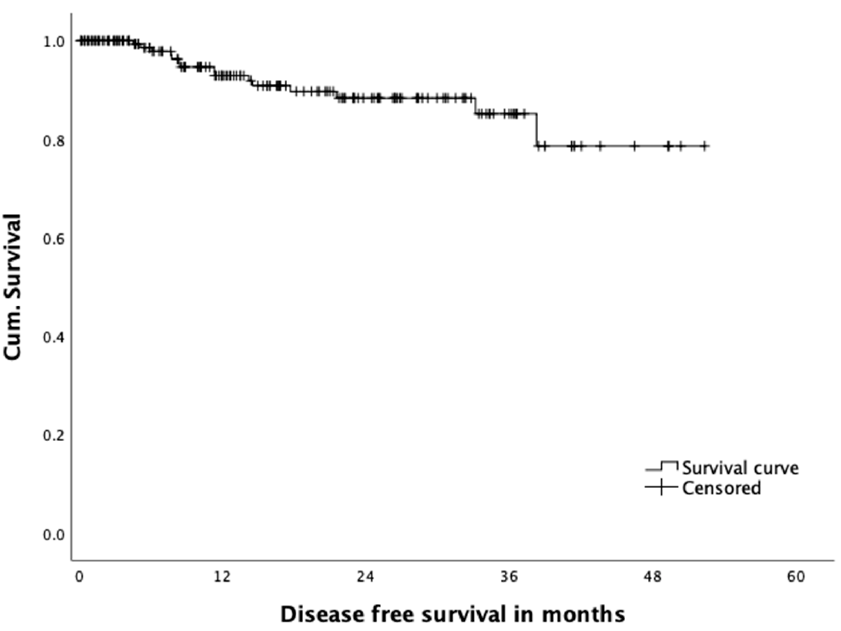
Figure 4. Overall disease free survival. Three patients (1.9%) were diagnosed with simultaneous local and systemic recurrence and further three patients (1.9%) with only local recurrence in the follow-up. A total of thirteen (8.3%) patients developed distant metastatic disease. Mean time to the occurrence of local and systemic recurrence did not differ significantly (14.2 vs. 13.9 months). Tumor recurrence significantly impacted overall patient survival (local and systemic) and is displayed in Figure 5 (36-month survival rate 41.1% in patients with tumor recurrence versus 89.3% without recurrence ( p = 0.001)). The impact of local recurrence versus systemic recurrence was compared separately in Figure 6, with a significantly reduced overall survival in patients with both local as well as systemic tumor recurrence ( p = 0.002).